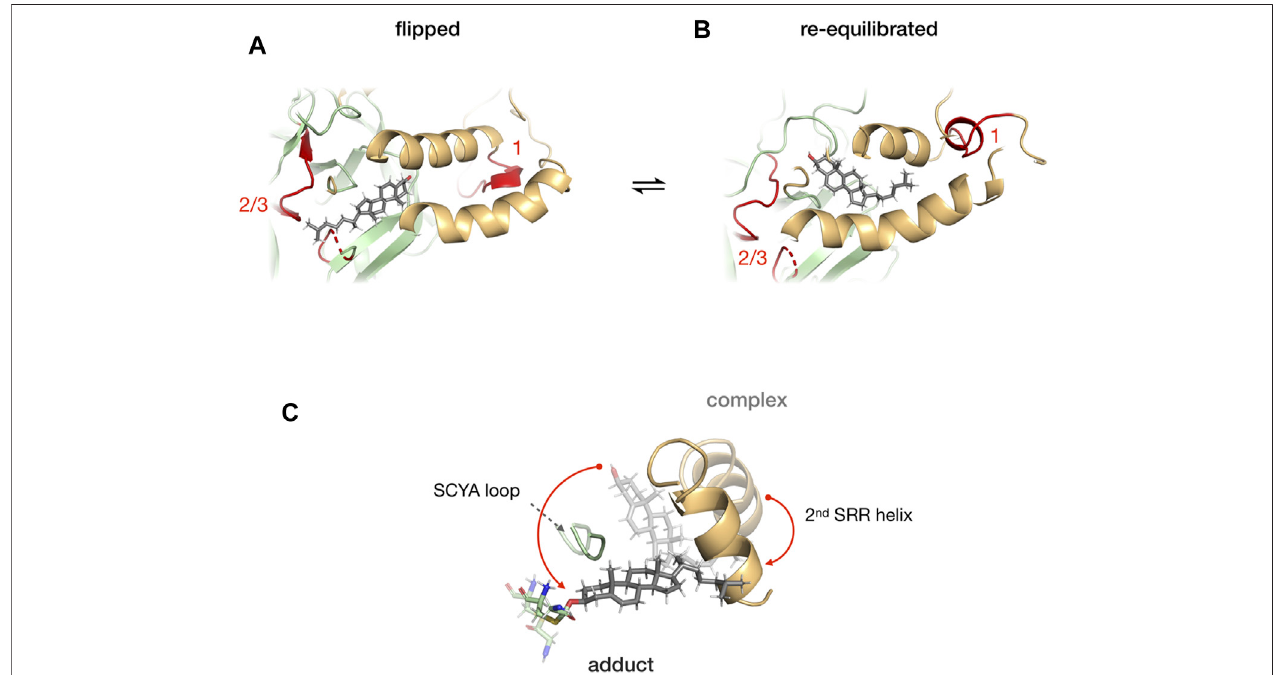
FIGURE10| CholesterolbindingattheHint-SRRinterface.Dynamicsofcholesterol-hogcomplexin fl ippedconformationwherecholesterolmolecule isrotatedby 180 ° relative to its original position with binding site 1 from SRR and 2/3 from Hint (in red) (A) . The cholesterol returns to its original position in 400 ns MD simulation (B) . Overlay ofcholesterol, 2nd helix, G258-C258 thioester, and SCYA loop from cholesterol-Hog complex and the Hog-cholesterol adduct (C) . The red arrow indicates the overall movement of the cholesterol. Figure from the reference, Ma fi et al. (Ma fi et al., 2021).